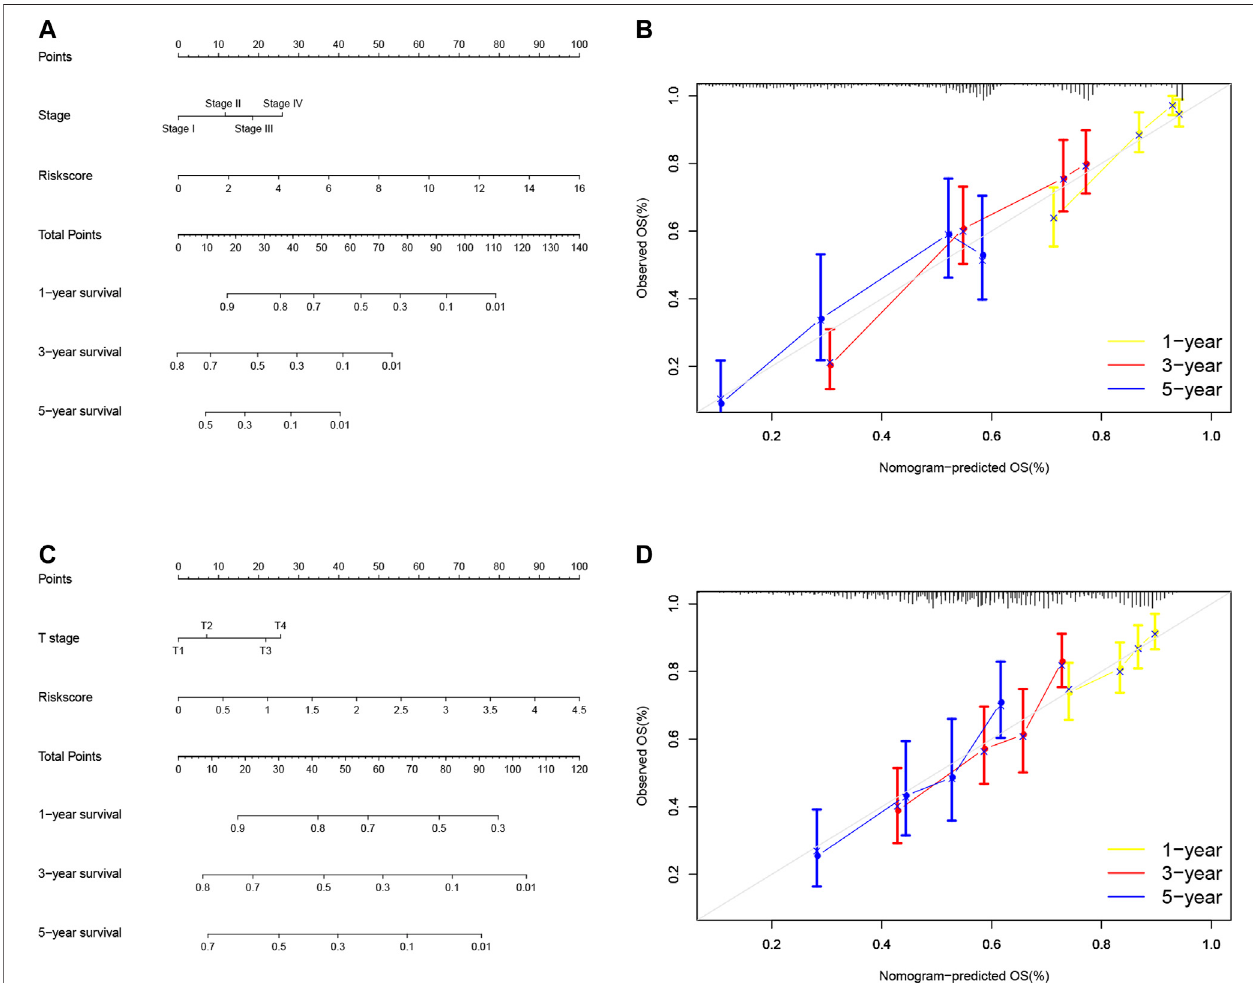
FIGURE 9 | Nomogram prediction of overall survival (OS) of LUAD and LUSC patients. (A) Construction of AS clinicopathological nomograms using AS risk signature and pathological stage. The nomogram was then used to predict the 1-, 3-, and 5-year OS of LUAD patients. (B) The nomogram AS clinicopathological nomogramcalibrationplotinLUAD.Itpredicts1-,3-,and5-yearprognoses. (C) ConstructionofASclinicopathologicalnomogramsusingASrisksignatureandTstage. Thenomogramwasthenusedtopredict1-,3-,and5-OSofLUSCpatients. (D) TheASclinicopathologicalnomogramcalibrationplot.Itpredictsthe1-,3-,and5- year prognosis of LUSC. AS, alternative splicing; LUAD, lung adenocarcinoma; LUSC, lung squamous cell carcinoma; OS, overall survival.